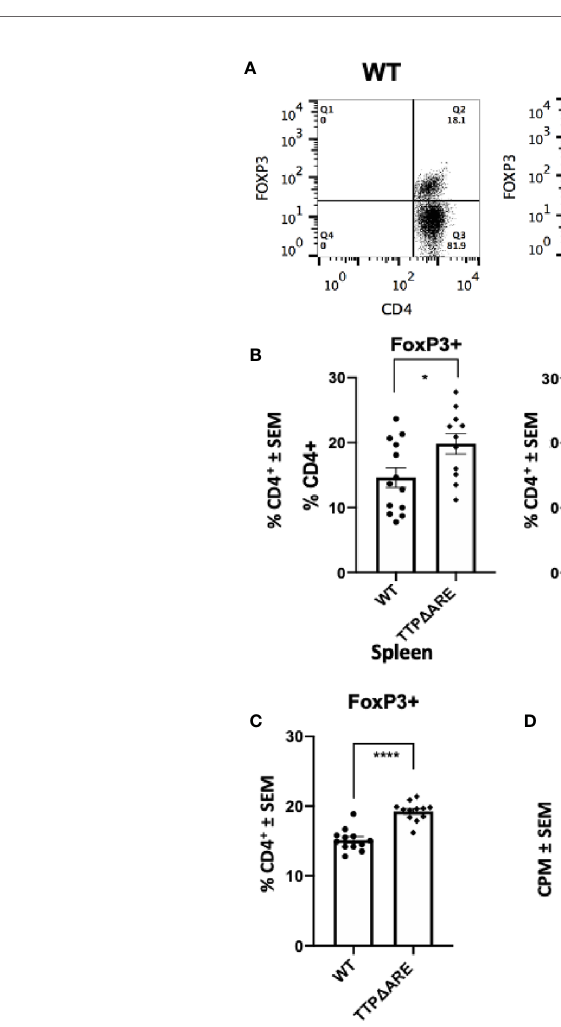
Figure 2C . The proportions of FoxP3+ cells were signi fi cantly higher in CD4 + cells from TTP D ARE mice than WT controls at steady state. To further elucidate the suppressive function of Treg cells in TTP D ARE mice, we conducted a standard Treg suppression assay. Sorted populations of CD4+CD25 HIGH cells from TTP D ARE mice were compared with those of the WT controls for their ability to inhibit anti-CD3 stimulated CD4 + CD25 - effector T-cell proliferative response in the presence of irradiated WT splenocytes as APC. The data shown in Figure 2D indicate that the Treg cells of the TTP D ARE mice were demonstrably more suppressive than their WT controls on a per-cell basis.